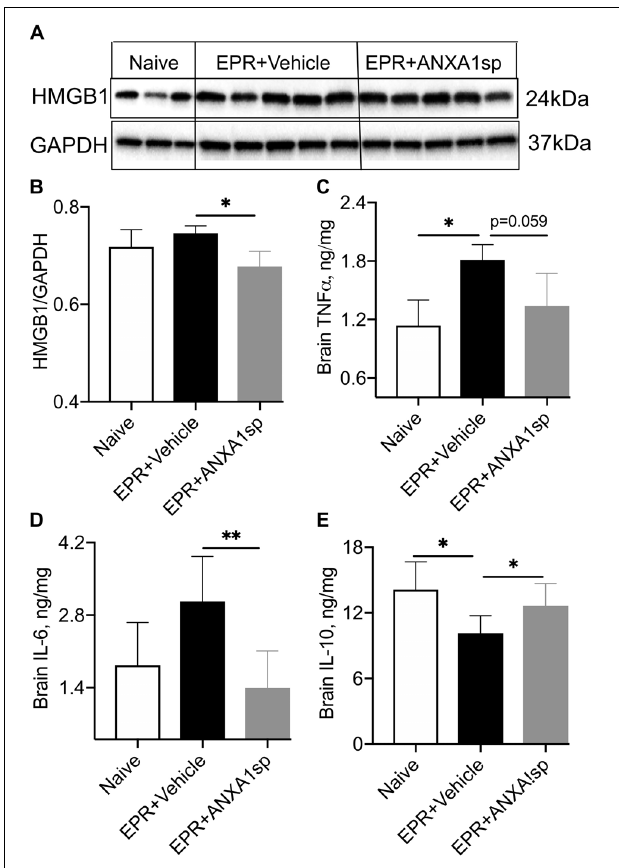
FIGURE 3 | Modulation of indices of neuroinflammation after EPR by experimental group. (A,B) High mobility group protein B1 (HMGB1) expression in brain homogenates from ANXA1sp-treated animals were significantly reduced compared to vehicle (controls). (C,D) Cerebral levels of tumor necrosis alpha (TNF α ) and interleukin 6 (IL-6) were increased in the vehicle controls, and reduced with systemic administration of ANXA1sp. (E) Cerebral interleukin 10 (IL-10) was significantly reduced after induction of profound hypothermia (EPR + vehicle) and restored with administration of ANXA1sp. Data presented as mean ± SD ( n = 3–7/group), ∗ P < 0.05 and ∗∗ P < 0.01 compared to vehicle controls or naïve animals, analyzed by one-way ANOVA with Tukey’s multiple comparisons test. GAPDH, glyceraldehyde-3-phosphate dehydrogenase.